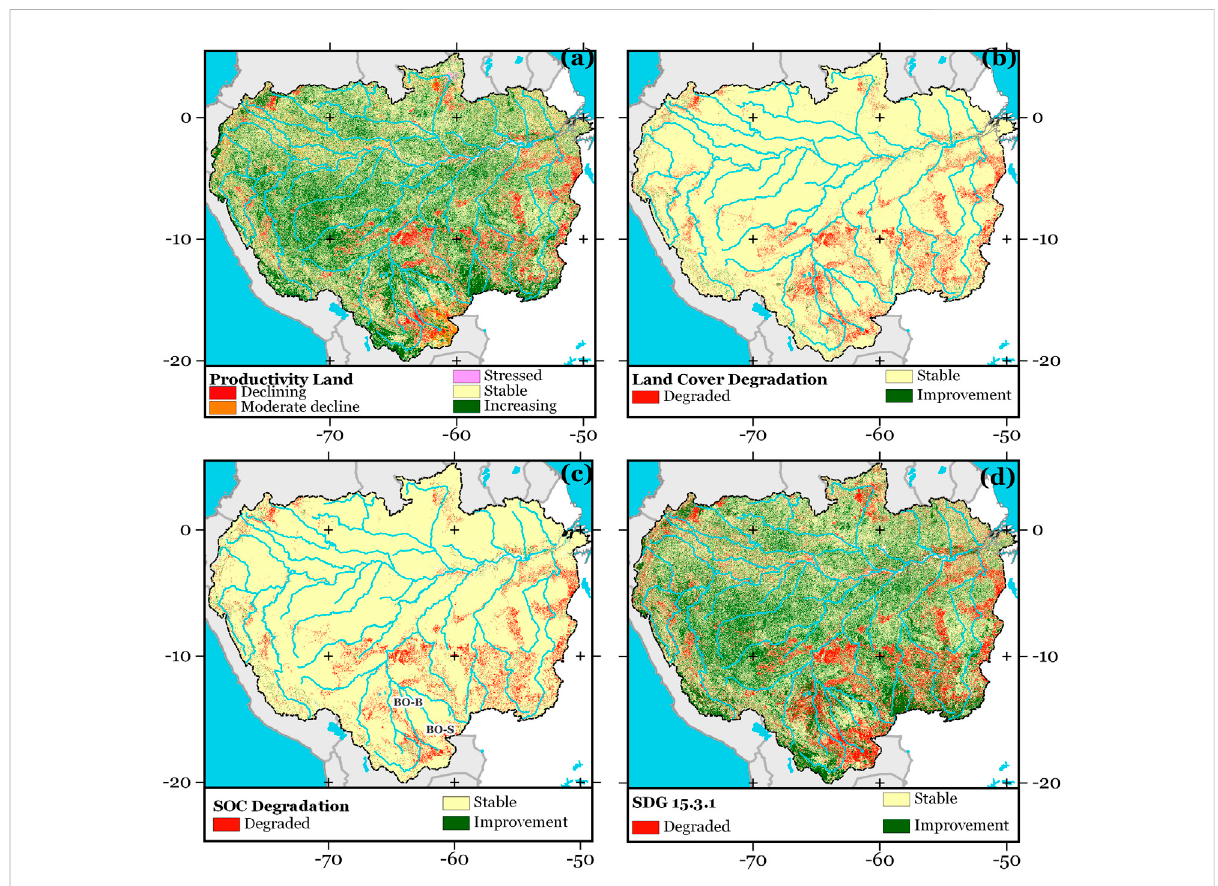
FIGURE 3 Map of the sub-indicators (A) land productivity; (B) land cover degradation; and (C) SOC degradation; together with (D) the SDG indicator 15.3.1 for the period 2001 – 2020. The location of the Bolivian states is shown as BO-B, El Beni; and BO-S, Santa